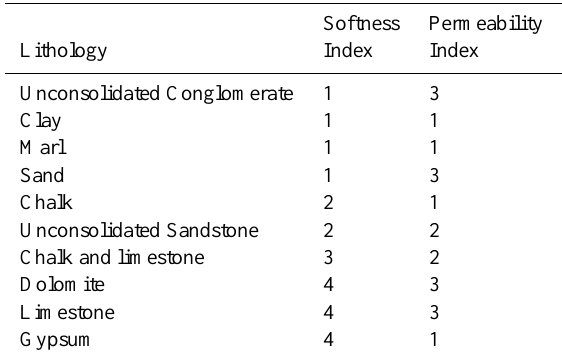
Table 1. Derivation of softness and permeability indices from litho- logical